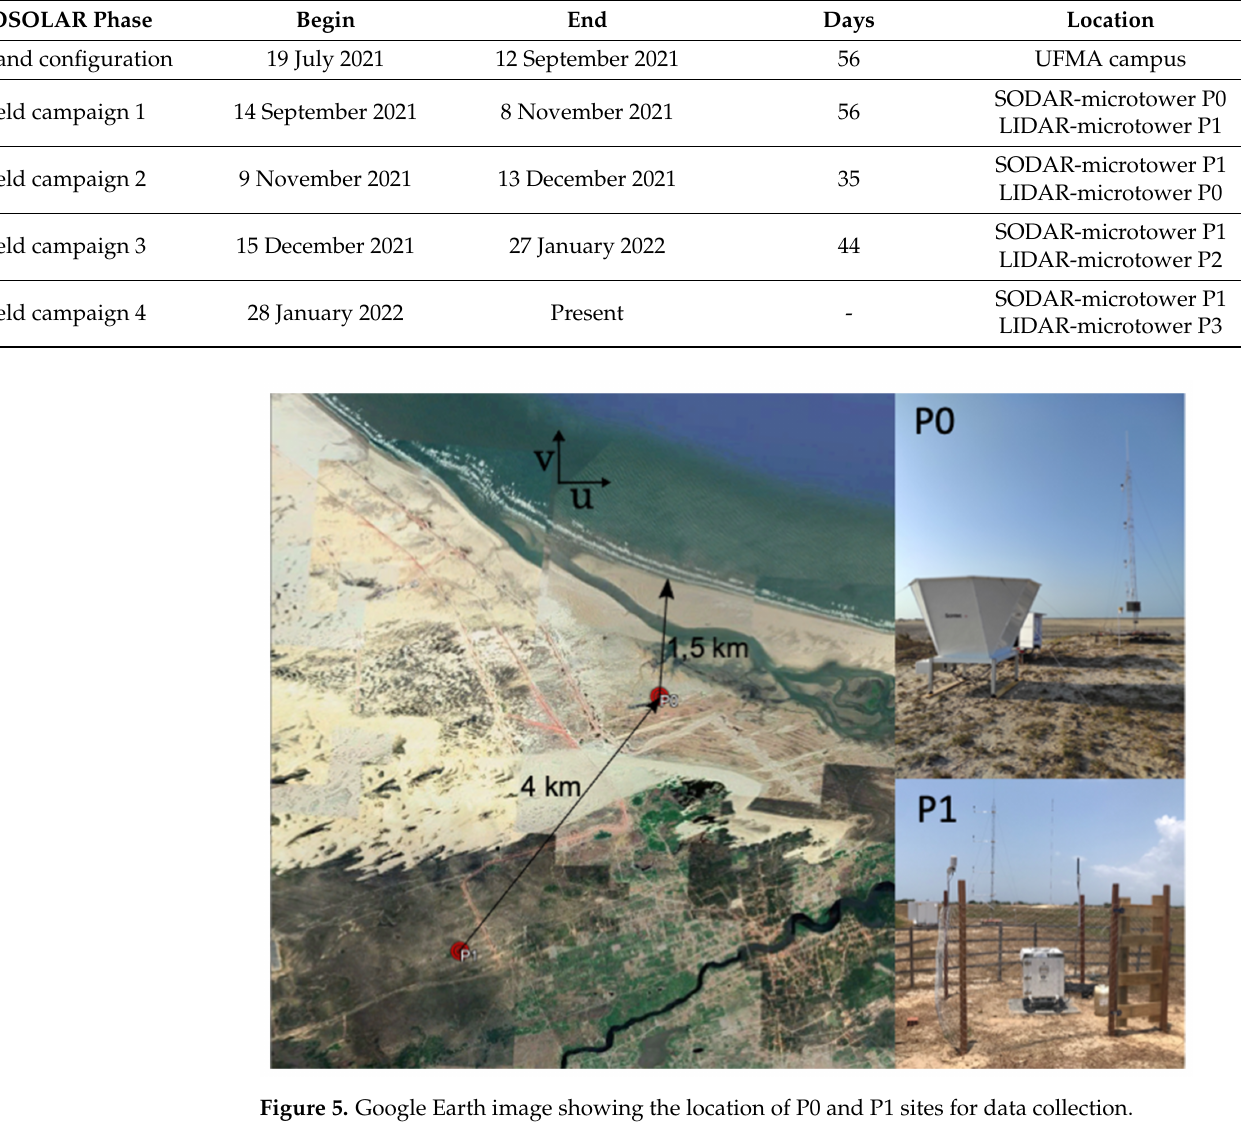
Table 2. EOSOLAR phases of operation with a test of equipment and field campaigns, where the LIDAR- microtower and SODAR-microtower sets were moved along the station’s positions indicated in Figure 1.